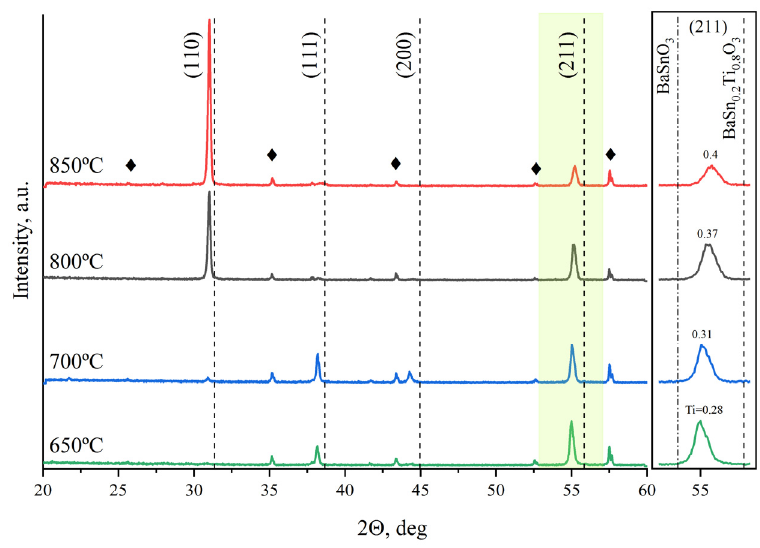
Figure 2. Diffractograms of the BTS thin films on Al 2 O 3 substrates at different substrate temperatures.